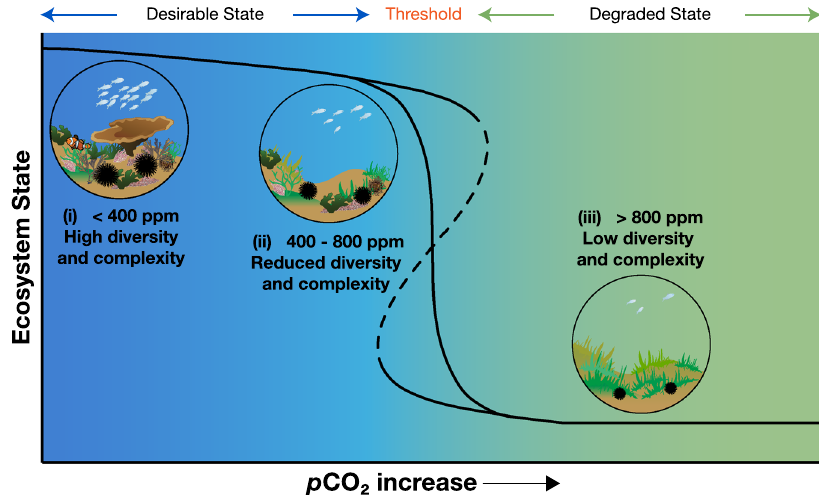
Fig. 2 Ecosystem shifts with rising seawater p CO 2 . Ocean acidi fi cation drives changes that lower coastal biodiversity and habitat complexity. Black solid line highlights a continuous shift (Forward threshold = Reverse threshold) from the ‘ Desirable Ecosystem ’ with high diversity and complexity, to the ‘ Degraded Ecosystem ’ with low diversity and complexity. The black dashed line highlights a discontinuous shift (Forward threshold ≠ Reverse threshold) where feedback mechanisms can hinder ecosystem recovery ( ‘ hysteresis ’ ).